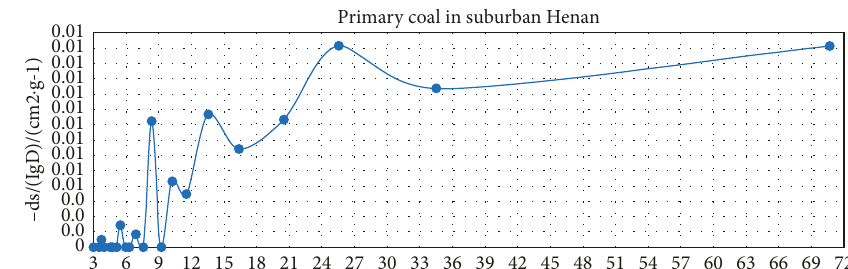
Figure 10: Distribution of pore specific surface area of